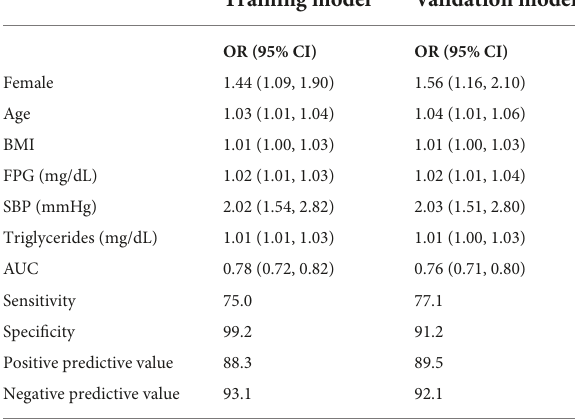
TABLE 4 Training and validation risk scores for the development of CKD c